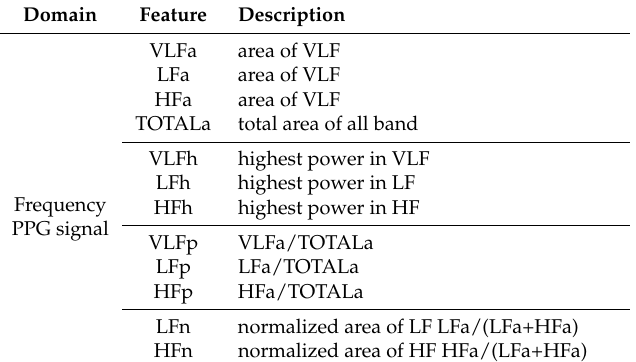
Table 2. Description of frequency domain features.